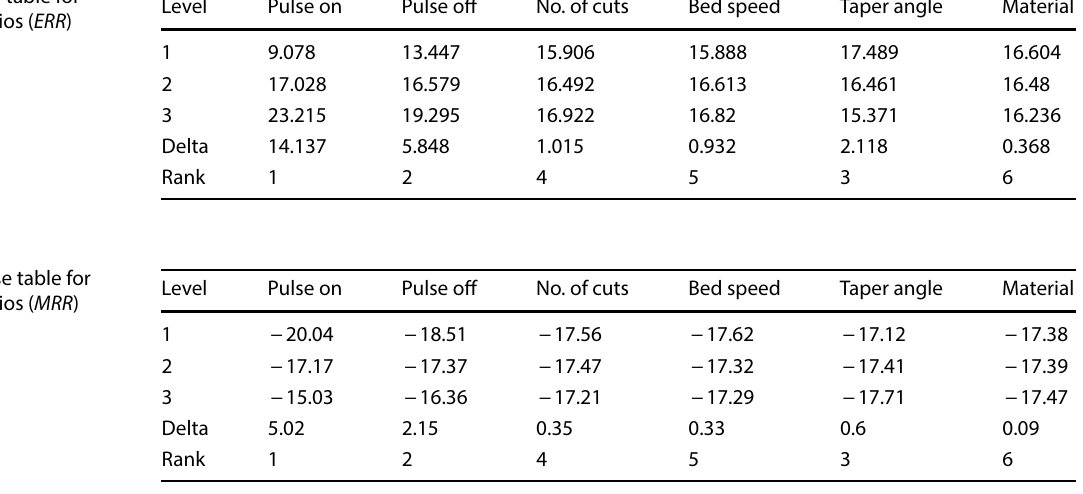
Table 9 Response table for signal to noise ratios ( ERR )